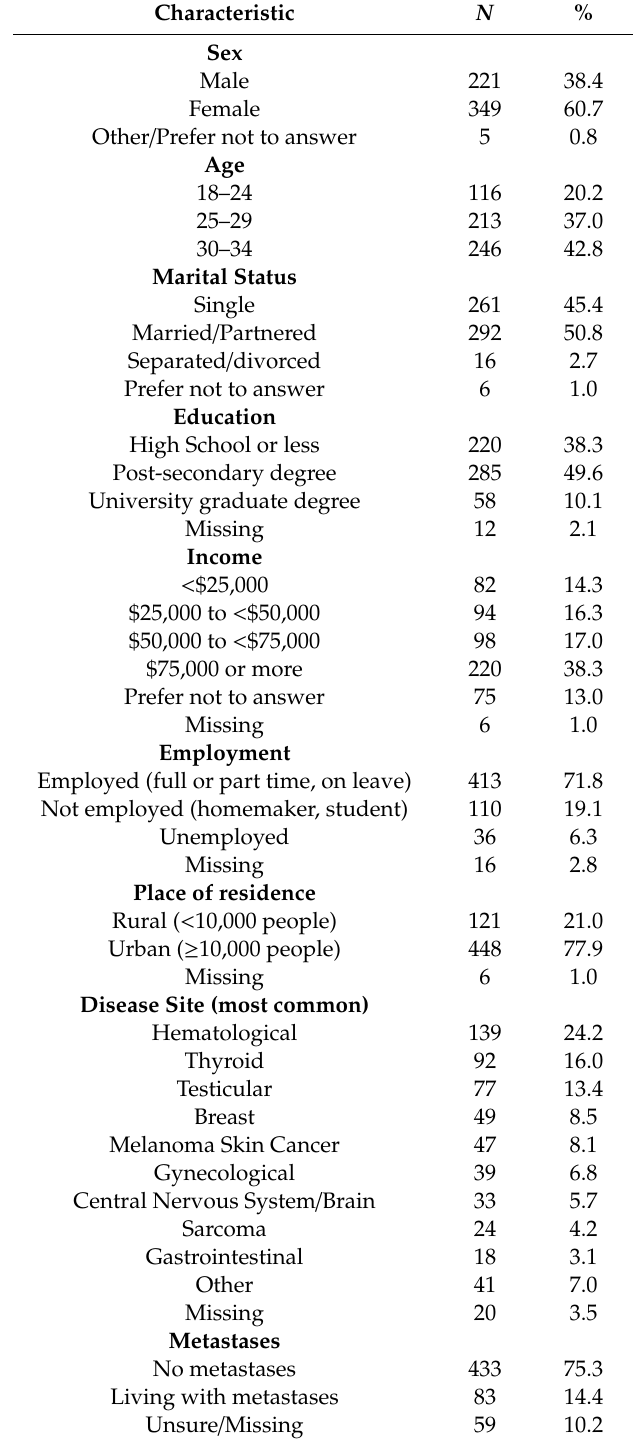
Table 1. Description of adolescents and young adults (AYAs) sample ( n =